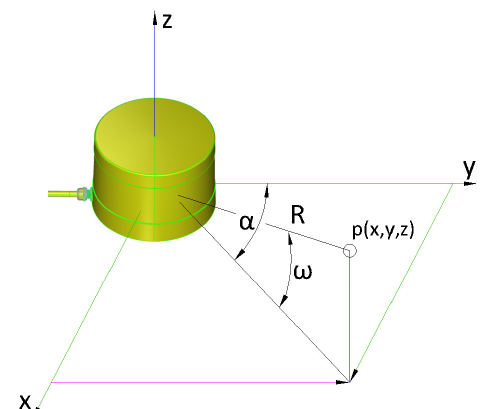
Figure 1. The interrelations between spherical polar coordinates of VLP-16 to x, y, z coordinates.